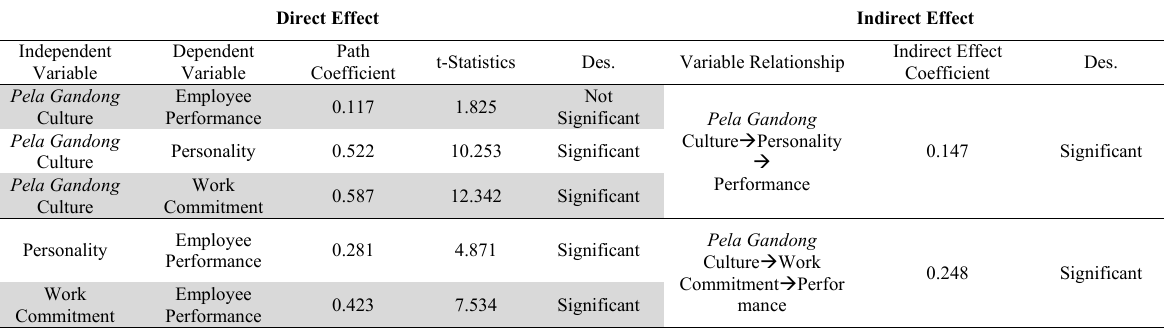
Testing Results of Direct and Indirect